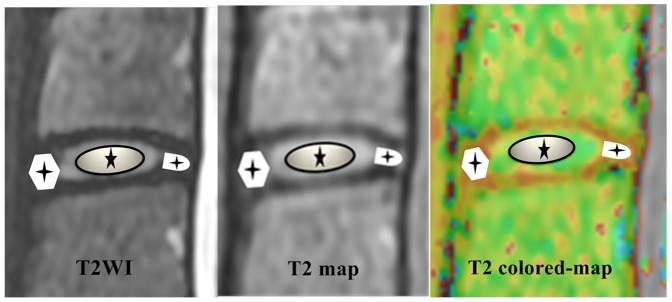
For the representative intervertebral disc, regions of interest (ROIs) evaluation on the sagittal T2WI, an ellipse ROI was selected for the nucleus pulposus (NP).Suitable ROIs for both the anterior and posterior annulus fibrosus (AF) were selected. Then these ROIs in T2WI were copied to the T2 map and T2 colored-map. T2 values were measured.